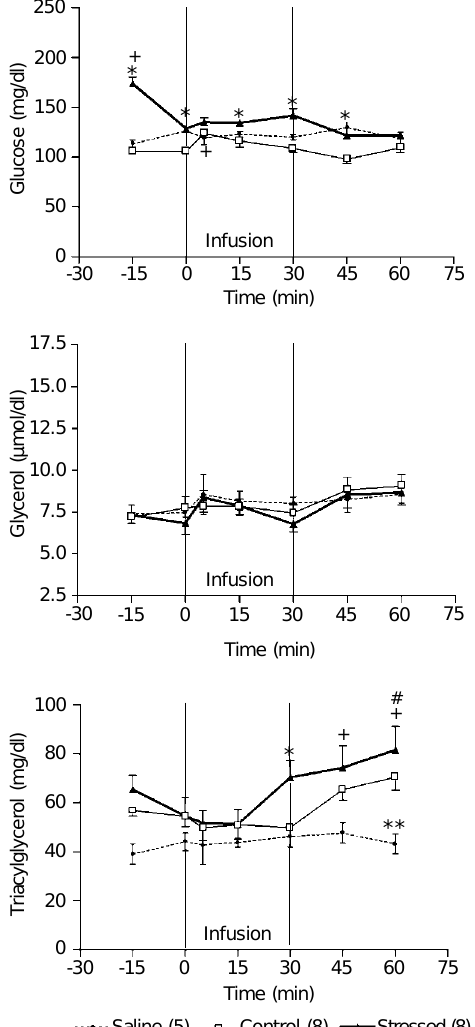
Figure 3. Effect of iv infusion of saline solution (0.9% NaCl, w/v) or isoproterenol (0.4 nmol kg -1 min -1 ) on plasma glucose, glyc- erol and triacylglycerol levels in fed conscious rats after three daily sessions of confinement in footshock cages with no foot- shocks (control) or with foot- shock stress for 30 min. The in- fusion (time 0) began 15 min af- ter the end of the third session. The points represent the means ± SEM of the number of rats indicated in parentheses. *P<0.05 compared to the control group; + P<0.05 compared to the value at 0 min; **P<0.05 compared to the values at 5, 15 and 30 min; # P<0.05 compared to the values at -15, 0, 5, 15, and 30 min in the control group (ANOVA plus Tukey